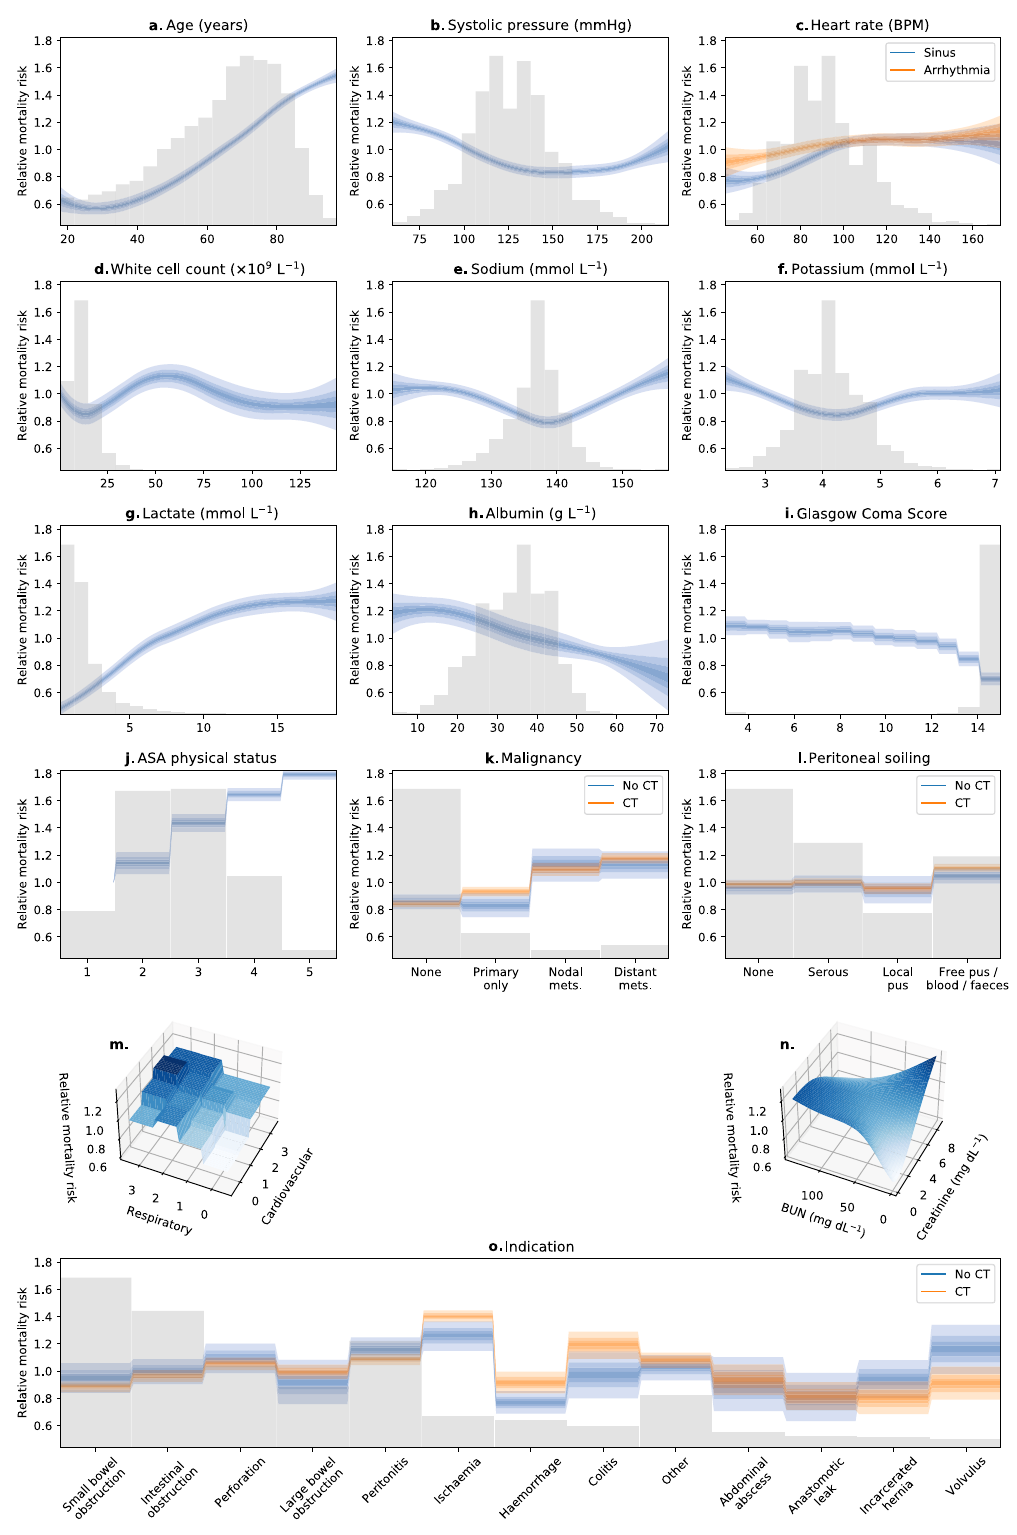
Fig. 2 Changes in predicted mortality risk with each RUNE variable. “ Partial dependence ” plots in panels a – o show how the mortality risk predicted by RUNE changes with each variable if the other variables are held fi xed. Blue and orange bands show changes in predicted mortality risk. In panels, a – l and o , the band ’ s width for each variable is proportional to the uncertainty of its association with mortality risk. From lightest to darkest, the four overlapping bands represent 95, 70, 45, and 20% con fi dence. Grey histograms show the distribution of each variable. Base categories are excluded. In panel m , respiratory status is encoded as 0: No dyspnoea, 1: Mild COPD or dyspnoea, 2: Moderate COPD or dyspnoea, 3: Fibrosis or consolidation or severe dyspnoea. Also in panel m , cardiovascular status is encoded as 0: No cardiac failure, 1: Cardiovascular medications, 2: Peripheral oedema or taking warfarin, 3: Raised jugular venous pressure or